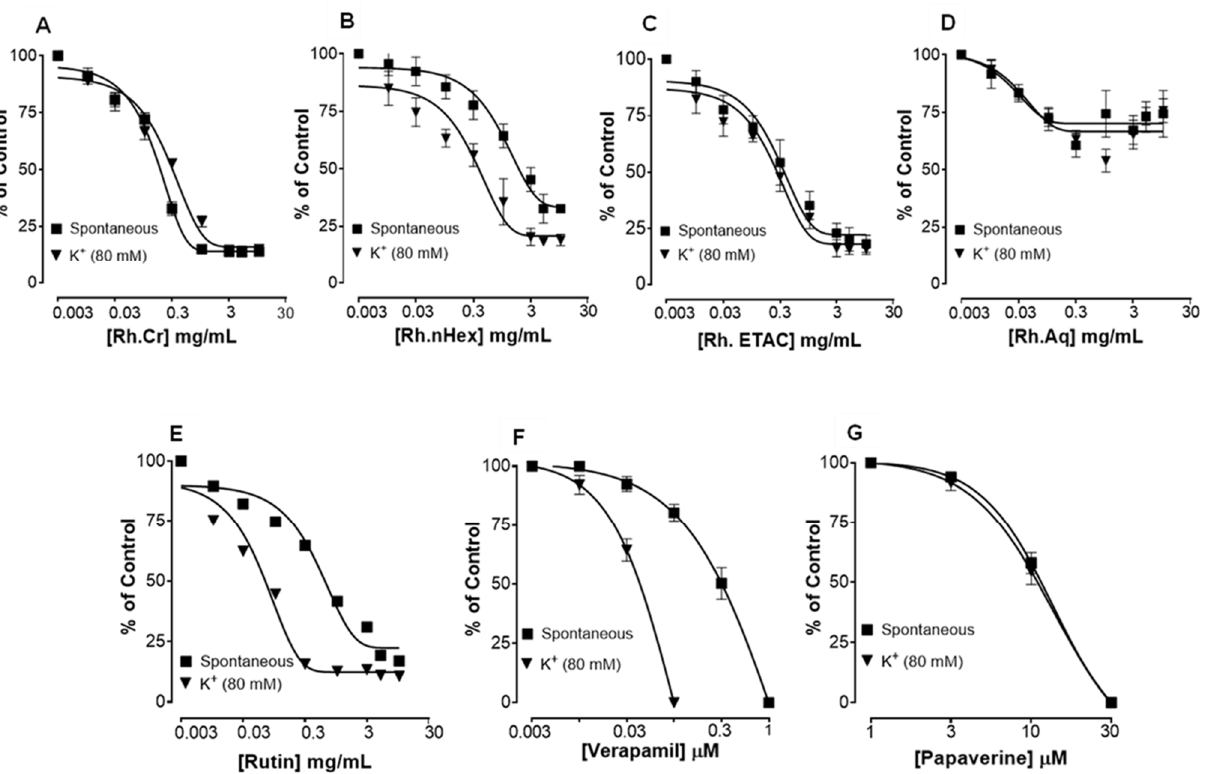
Figure 2. Concentration-dependent inhibitory effect on spontaneous and K + (80 mM) induced contractions of ( A ) Rumex hastatas crude extract (Rh.Cr) and fractions: ( B ) n-hexane (Rh.n-Hex), ( C ) ethyl acetate (Rh.ETAC), ( D ) aqueous (Rh.Aq), ( E ) rutin ( F ) verapamil and ( G ) papaverine in isolated rabbit jejunum preparations. Values are expressed as mean ± SEM ( n = 4–5).